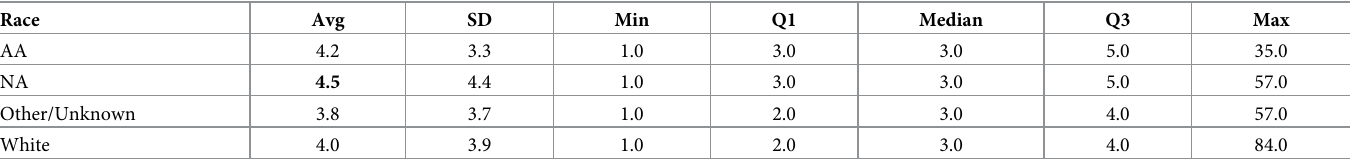
Table 8. Length of stay by race for patients with PE in Oklahoma PUDF. We report the average (Avg), standard deviation (SD), minimum (Min), first quartile (Q1), median, third quartile (Q3), and maximum (Max) values. Race Avg SD